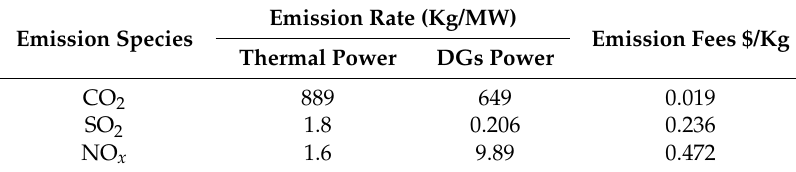
Table 3. Emission characteristics and cost